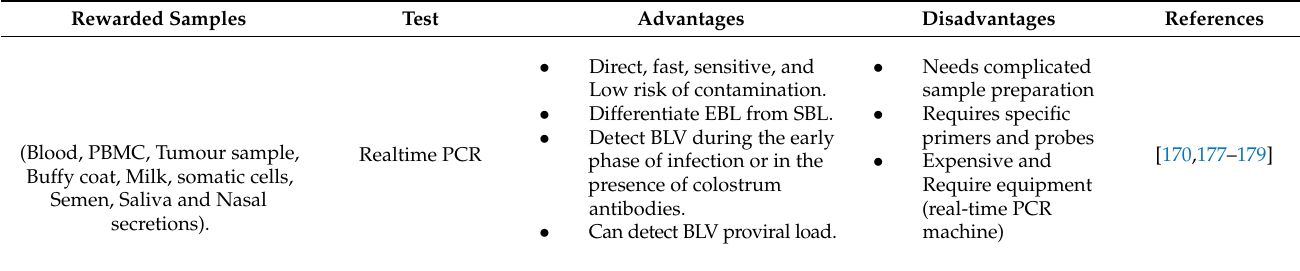
Table 4. Molecular techniques used for diagnosis of BLV prevalence according to the rewarded samples and test sensitivity (All detect proviral DNA), adopted from